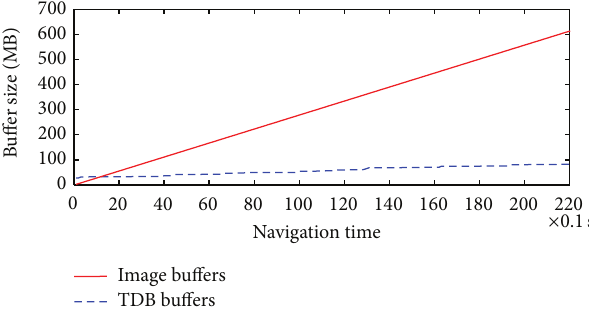
Figure 14: Buffer sizes of the TDB and the captured video images. Although the speed by using the color mesh is around 27.5 fps, the visualization quality is much lower than that by using the texture mesh.